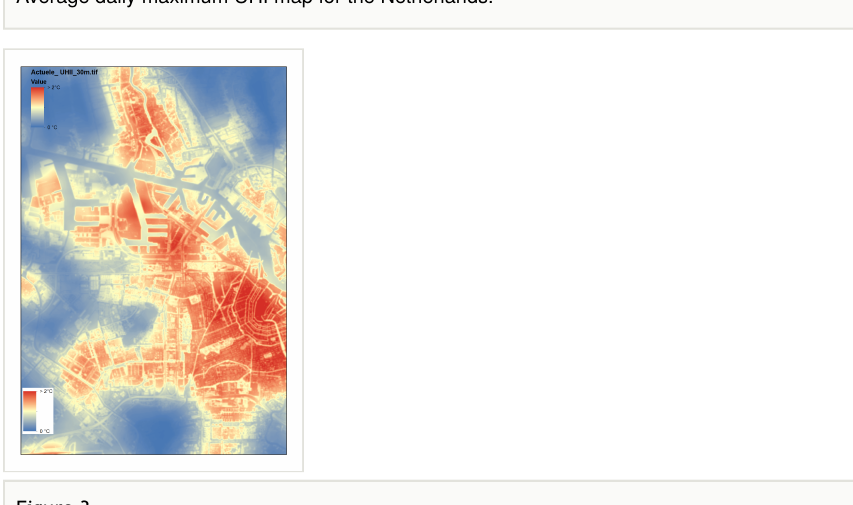
Average daily maximum UHI map for a part of the city of